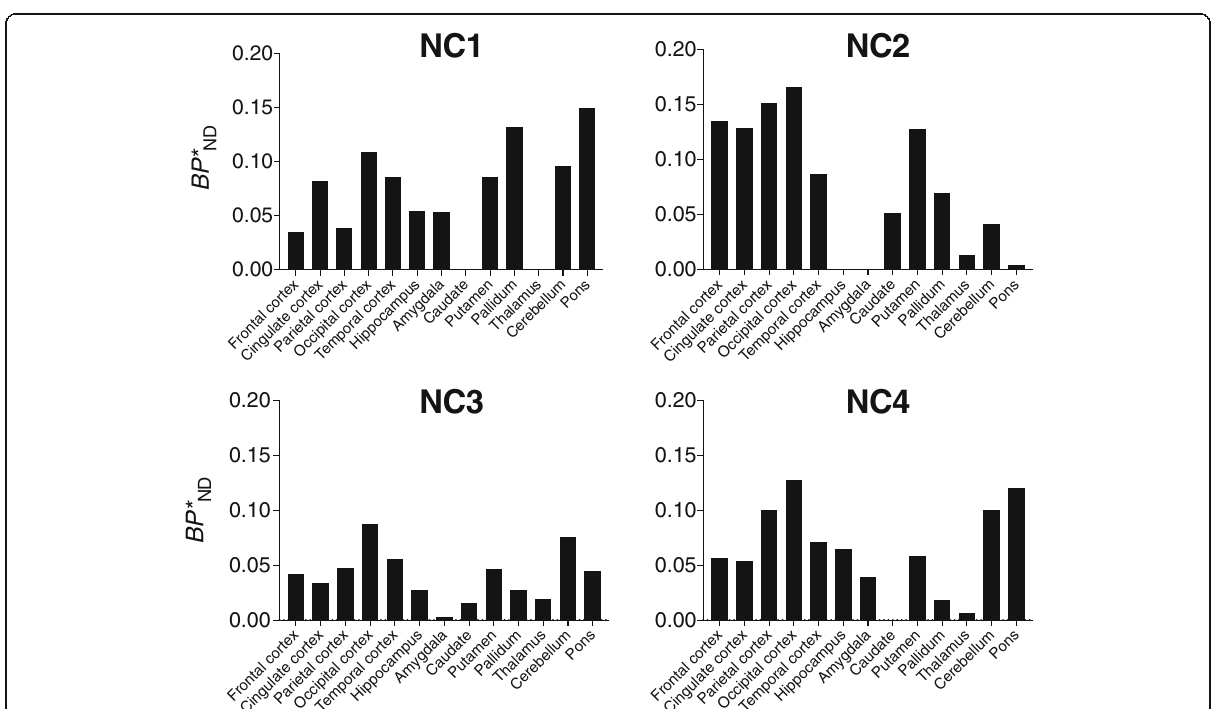
Fig. 6 Regional binding potential values ( BP * ND ) estimated by region-of-interest-based MRTM O with centrum semiovale as reference tissue in four subjects